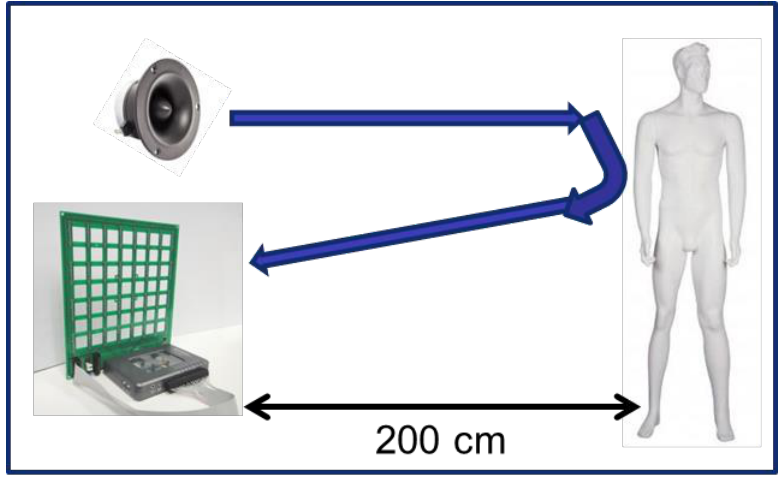
Figure 9. SONAR (SOund Detection And Ranging) principle.